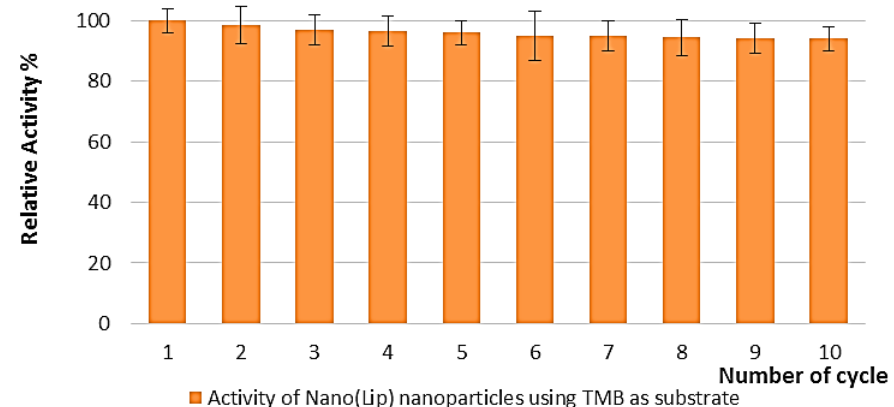
Figure 6. Reusability of the Nano-LiP particles.